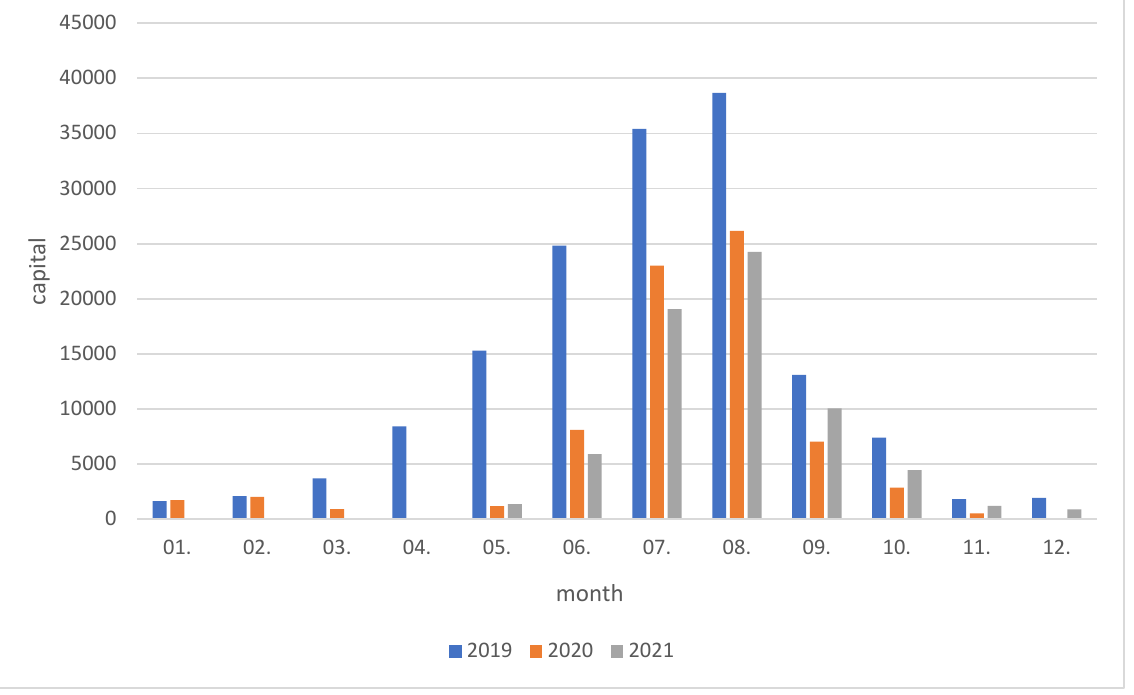
Figure 4. Visitor numbers in 2019, 2020 and in 2021. Resource: own design based on the dataset of the Benedictine Abbey in Tihany. Set of the visitors related the 3 years (cap.)